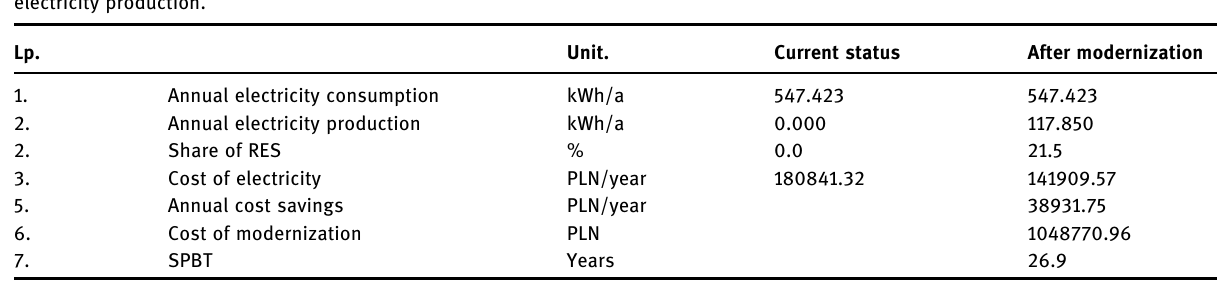
Table 6: Payback time for the photovoltaics at the ice rink Assessment and selection of a project to reduce electricity costs Description Electricity cost: